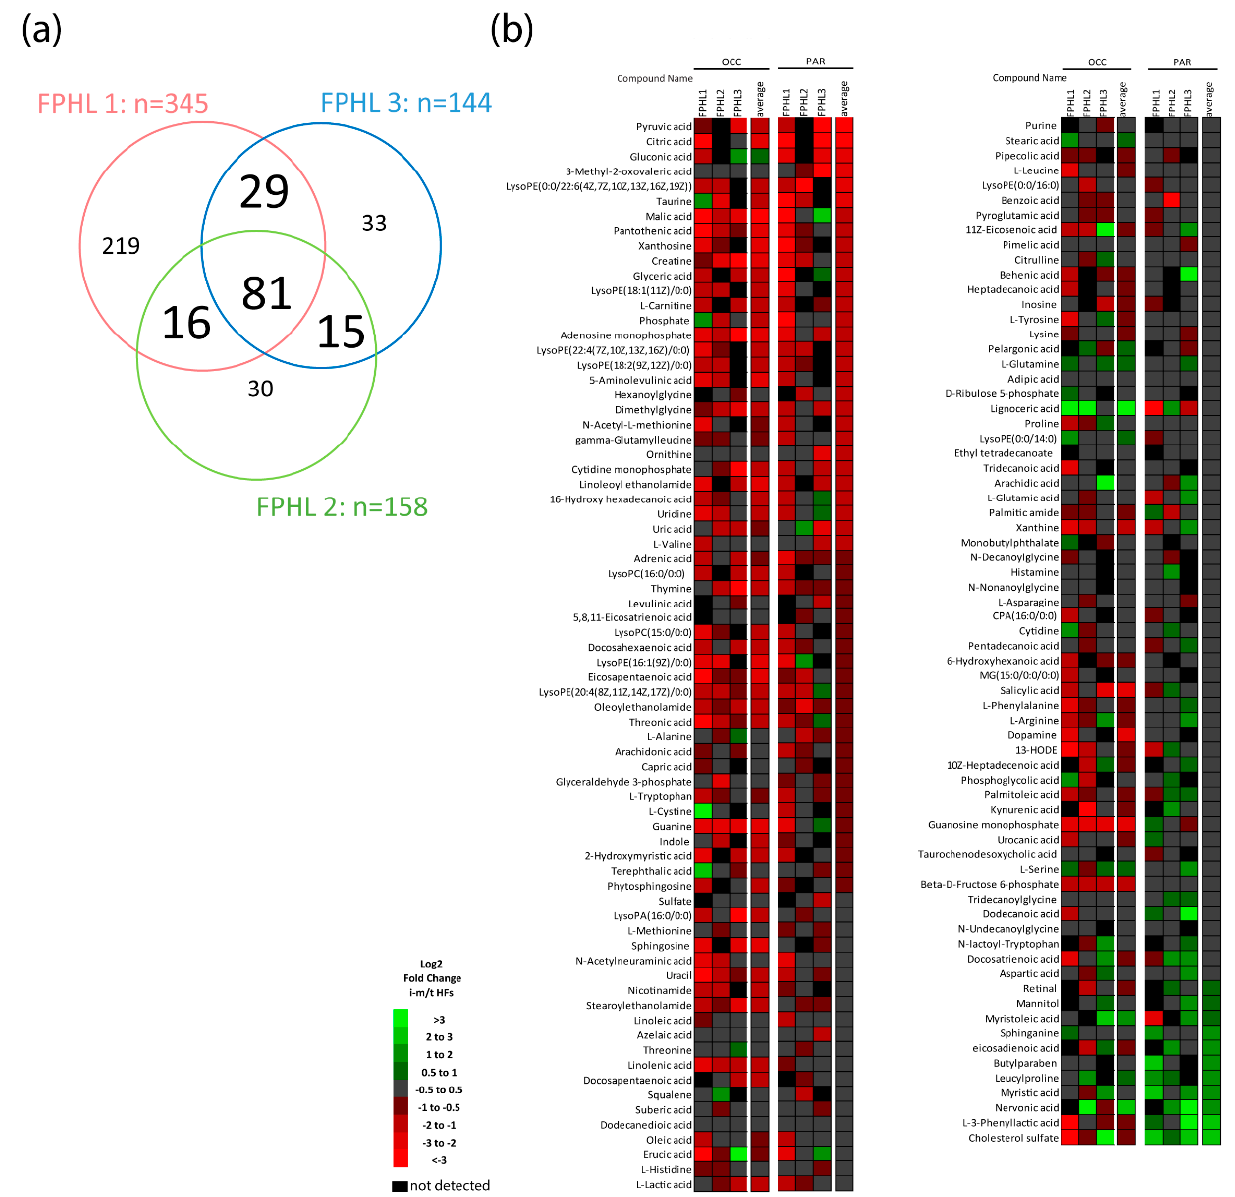
Figure 1. Untargeted metabolomic analysis of terminal and intermediate hair follicles from FPHL patients. ( a ) Number of metabolites identified by UPLC-MS analysis in n = 3 − 6 pooled terminal and n = 5 − 6 pooled intermediate/miniaturized hair follicles from the occipital and parietal scalp from n = 3 Female Pattern Hair Loss (FPHL) donors. n = 81 metabolites were identified in all three FPHL patients, n = 16 metabolites were commonly identified only in FPHL patients 1 and 2, n = 15 were commonly identified only in FPHL patients 2 and 3, and n = 29 were commonly identified only in FPHL patients 1 and 3. ( b ) Relative expression of the n = 141 metabolites identified in at least two FPHL patients. Heat maps show the Log2 fold change (FC) expression between intermediate/min- iaturized and terminal hair follicles (i-m/t) in the occipital (OCC) and parietal (PAR) scalp region of each FPHL patient (FPHL1, FPHL2, and FPHL3) and the Log2 fold change (FC) average expression from the n = 3 FPHL donors.